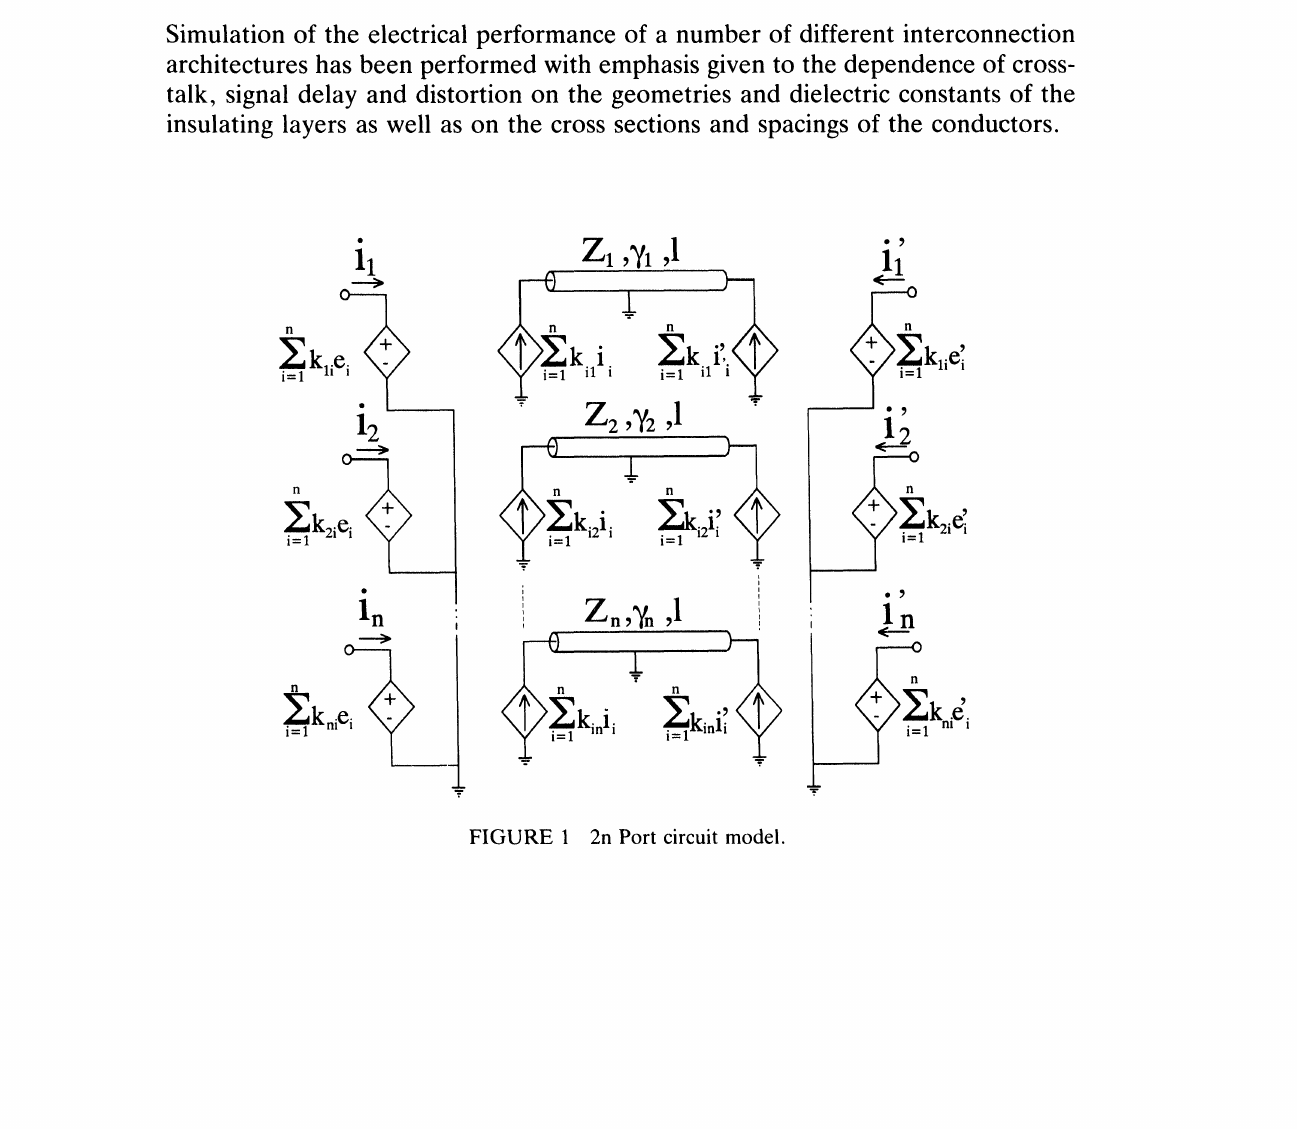
FIGURE 2n Port circuit